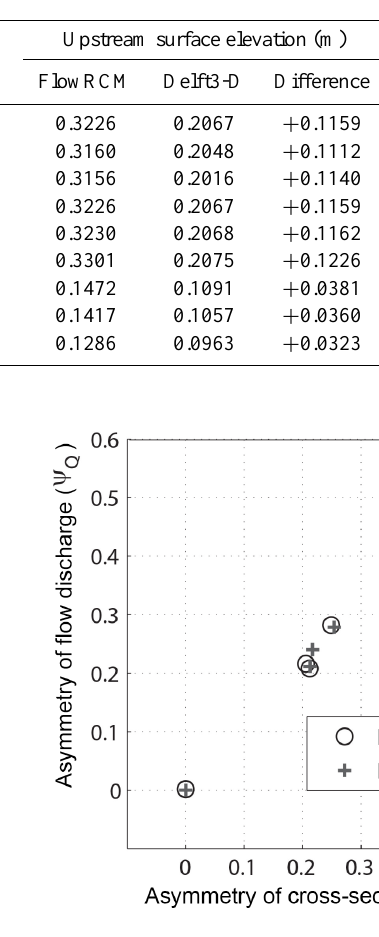
Figure 8. Comparison of discharge asymmetry as a function of cross-sectional area asymmetry predicted by FlowRCM and Delft3D. Both models result in asymmetry of discharge propor- tional to the asymmetry of cross-sectional